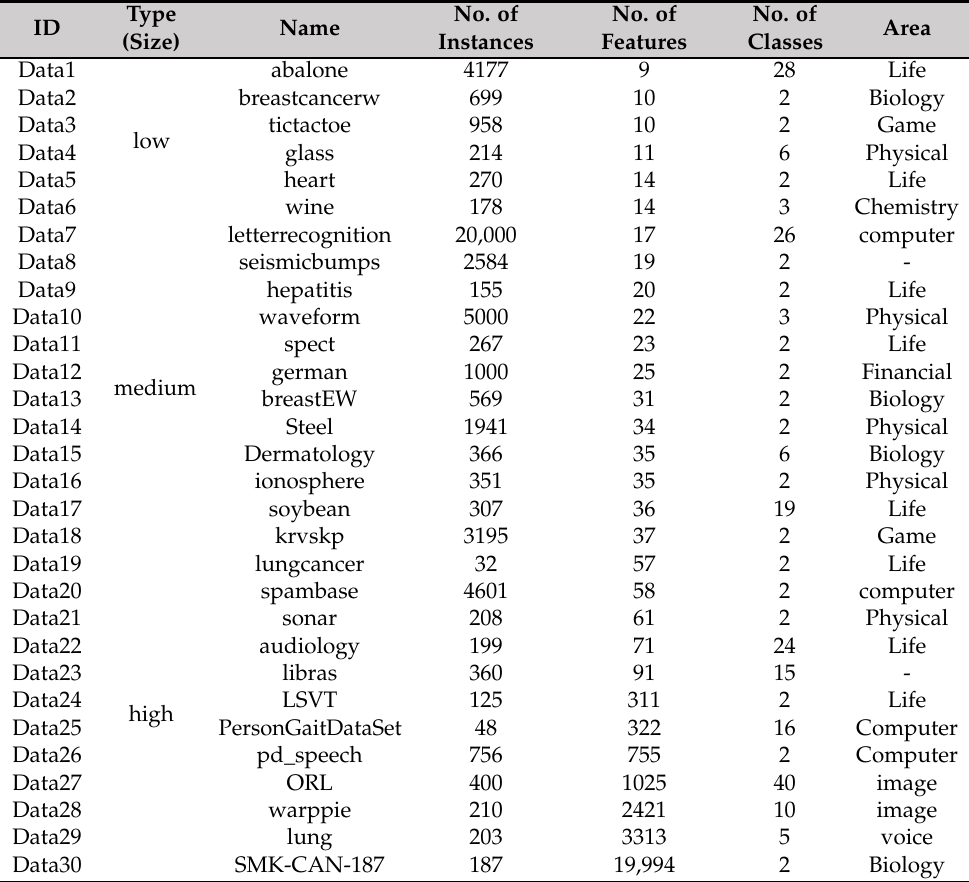
Table 1. Different types of data sets have been used in this